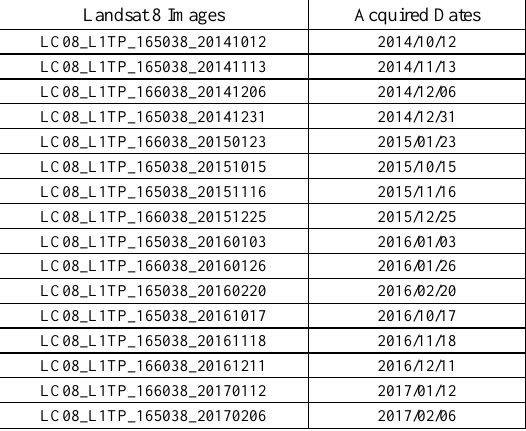
Figure 1. Location of Imam Khomeini Sugarcane Agro-industry